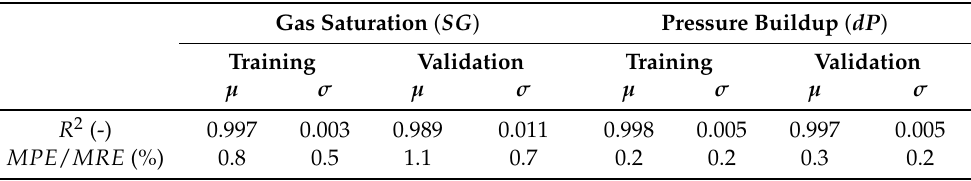
Table 2. A summary of the R 2 scores and the MPE / MRE of the gas saturation and pressure buildup models. µ denotes the mean, and σ denotes the standard deviation. µ and σ were calculated across 500 random samples from the training and validation set. The mean plume error ( MPE ) was calculated for the gas saturation model, and the mean relative error ( MRE ) was calculated for the pressure buildup model and were normalized on a scale from 0 to